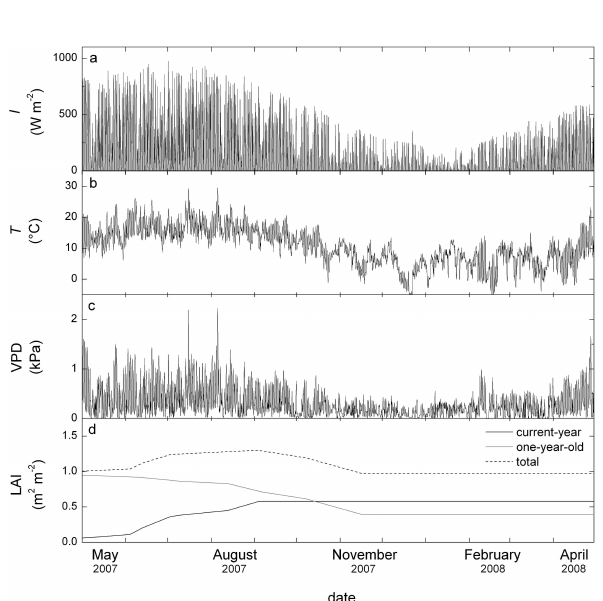
Fig. 1. Time courses of the half-hourly meteorological variables (a) incoming solar irradiance ( I) , (b) air temperature ( T ) , (c) air vapour pressure deficit (VPD), and of (d) leaf area index (LAI) of current- year needles (black line), one-year-old needles (grey line) and all needles (dotted line), over the phenological year May 2007–April